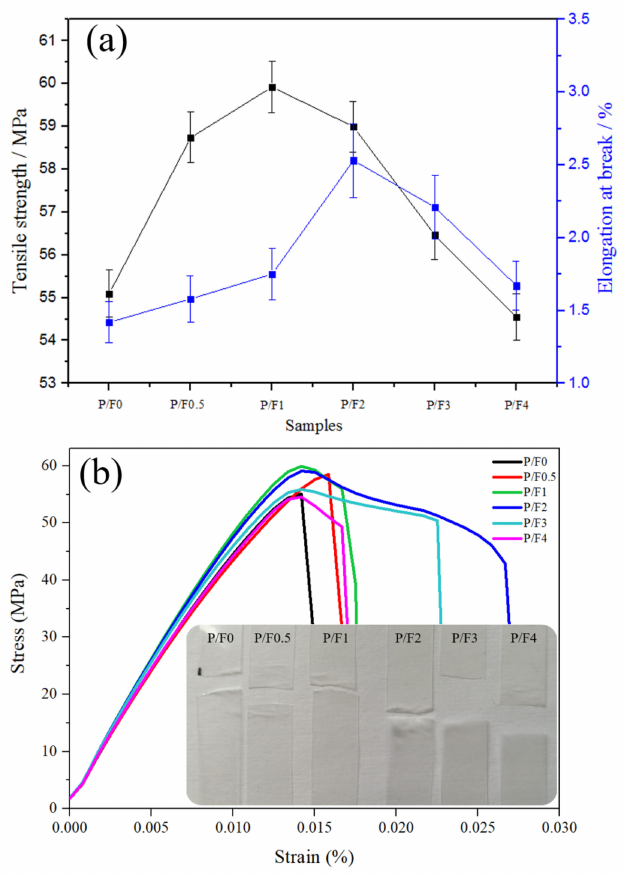
Figure 2. ( a ) Mechanical properties and ( b ) tensile stress–strain curves of P/F